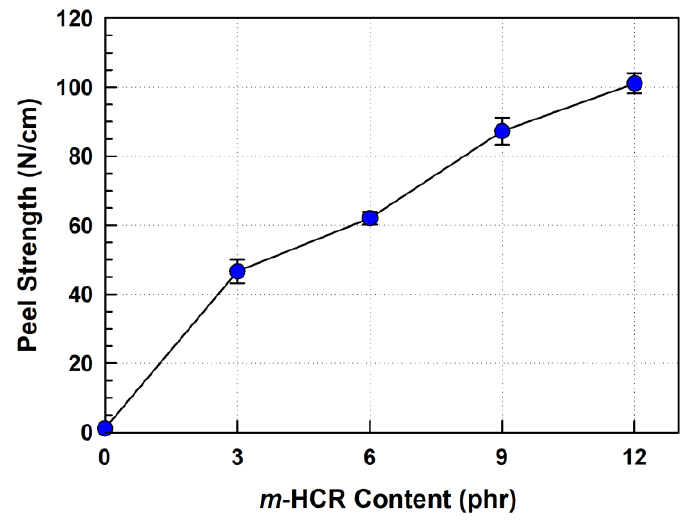
Figure 6. Peel strength of the crosslinked neat POE and POE blends with m